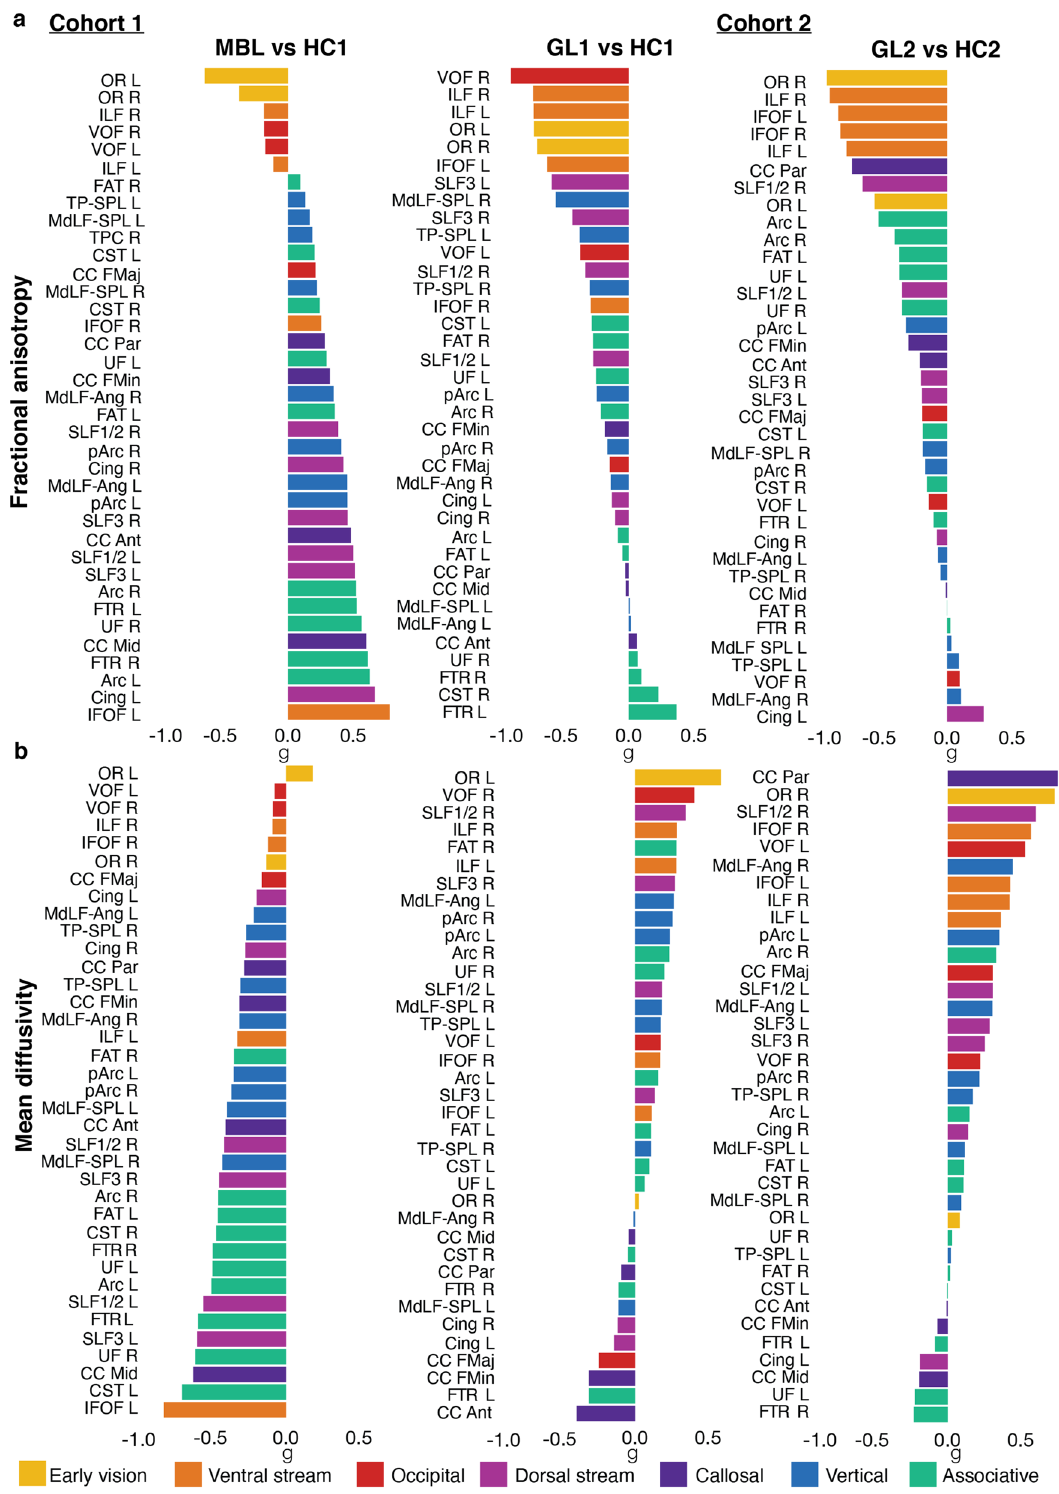
Figure 2. Ordered effect sizes in glaucoma and monocular blindness for each white matter tract. ( a ) Fractional anisotropy (FA). ( b ) Mean diffusivity (MD). Effect sizes were calculated using Hedges’ g by comparing the average FA or MD values from each WM tract profile. For each white matter tract, FA (or MD) in the glaucoma patients of the first (GL1) or second (GL2) cohort was compared to the corresponding tract in healthy controls (HC1 or HC2 respectively.) Similarly, FA (or MD) in the monocular blind patients (MBL) was compared to the corresponding healthy controls (HC1). Tracts are ordered by effect size with positive effect size presented first (top). WM tract acronyms are fully described in the Supplementary